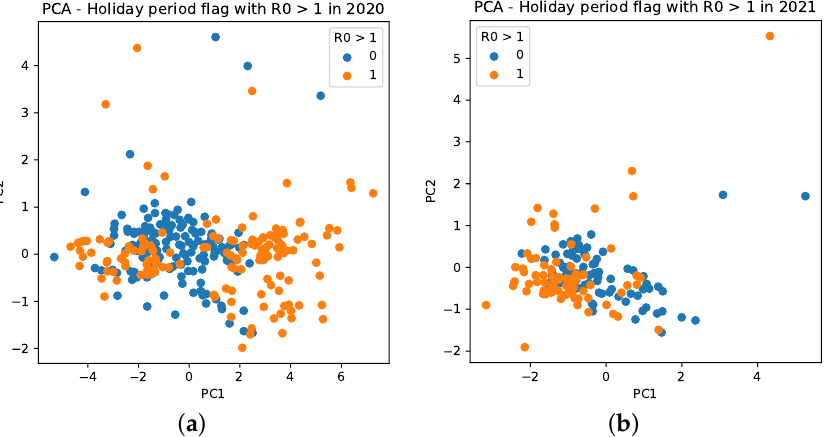
Figure 15. Cluster based on scattering of PC values using mobility data during the COVID-19 epidemic in Brazil. A point with a value of 0 indicates that it is not a holiday, whereas a value of 1 indicates that it is a holiday period. ( a ) PC scattering based on mobility reports considering R 0 > 1 and holiday period in 2020. ( b ) PC scattering based on mobility reports considering R 0 > 1 and holiday period in 2021.